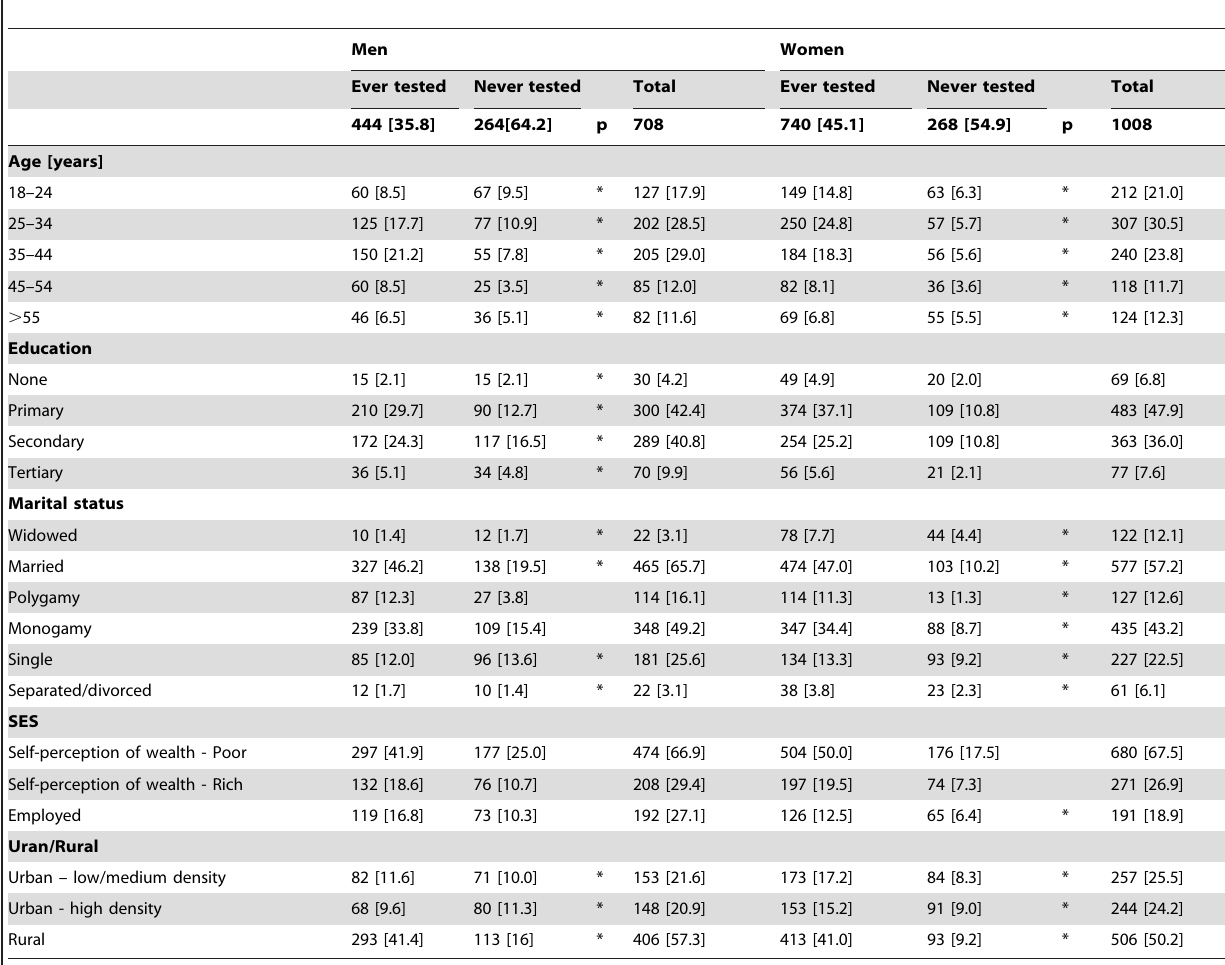
Table 1. Descriptive characteristics of respondents by gender and testing